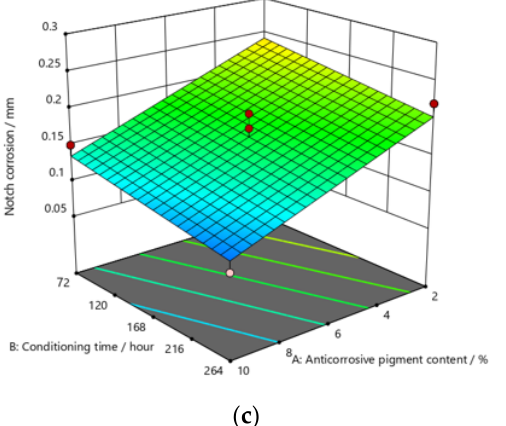
Figure 10. Response surface for regression model of notch corrosion for coating thickness of ( a ) D 1,